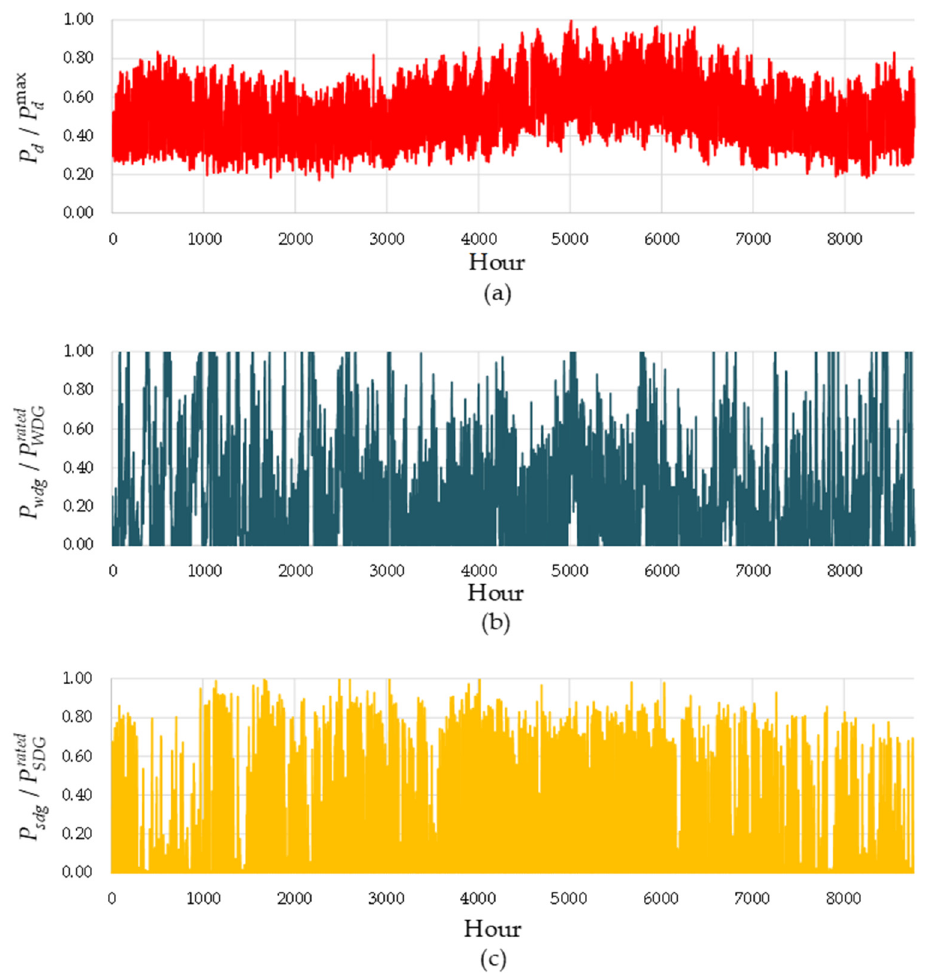
Figure 2. Hourly profile of: ( a ) load demand, ( b ) wind generation, and ( c ) solar generation of a year.